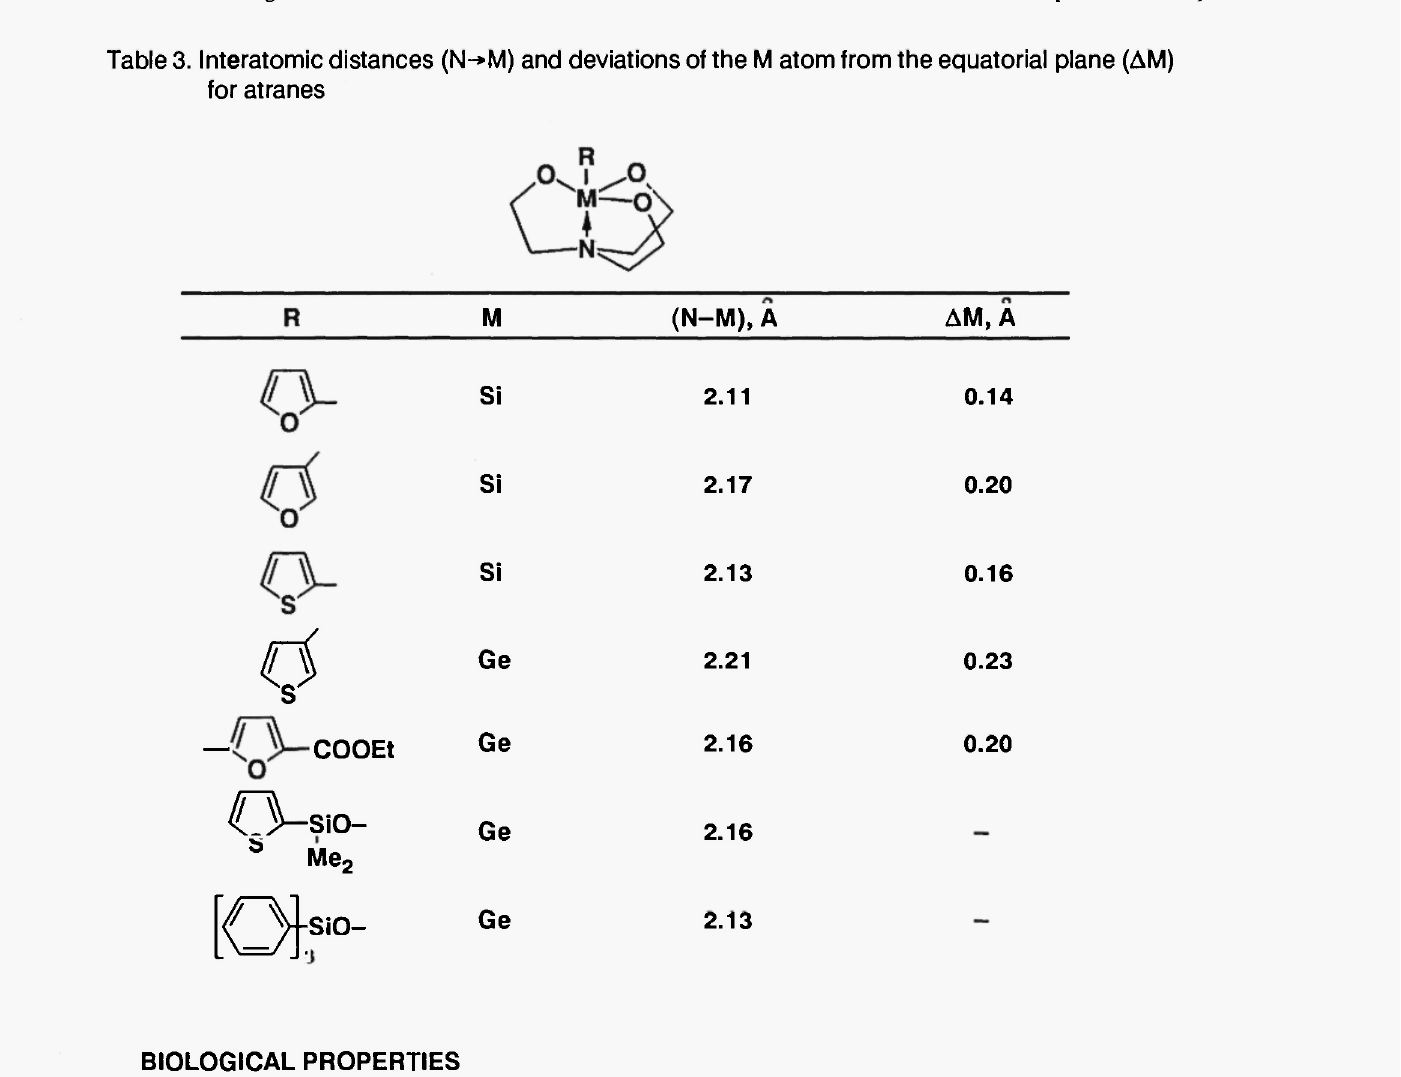
Table 3. Interatomic distances (N-»M) and deviations of the Μ atom from the equatorial plane (ΔΜ) for